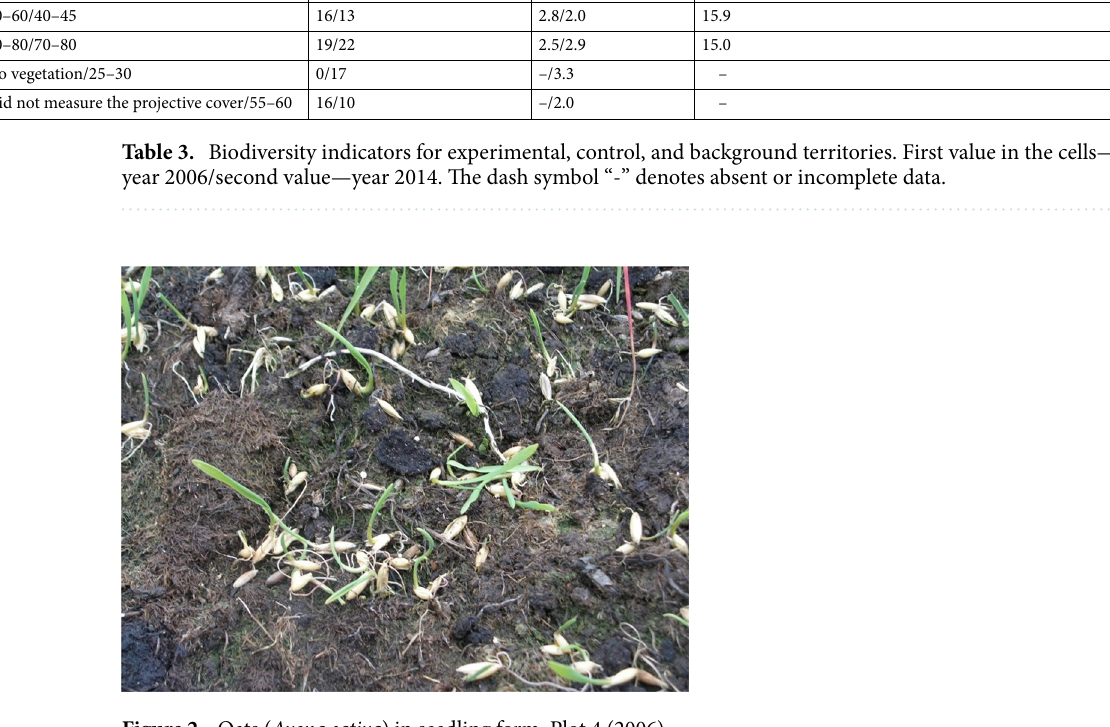
Figure 2. Oats ( Avena sativa ) in seedling form. Plot 4 (2006).